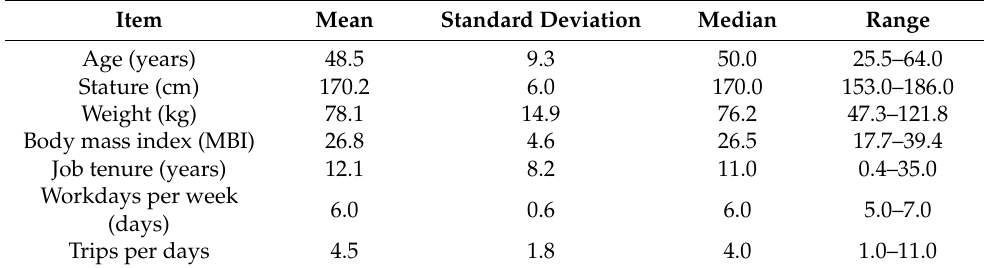
Table 1. Basic information on the 145 respondents.